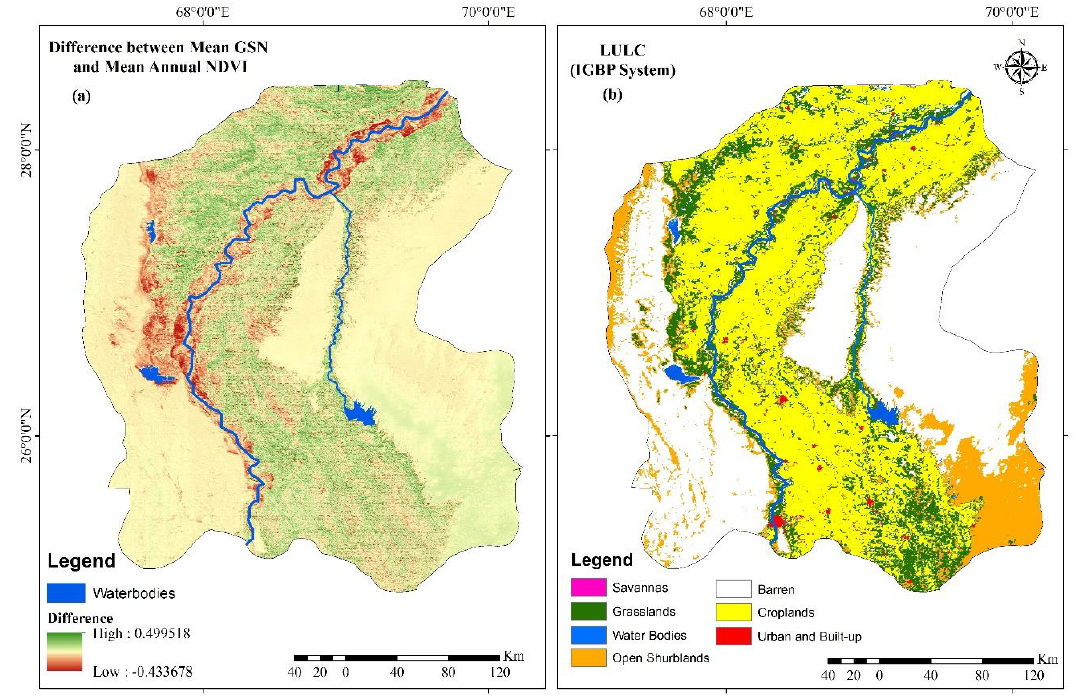
Figure 2. ( a ) Difference between Mean growing season (GS) and Mean Annual Normalized Difference Vegetation Index (NDVI) and ( b ) land cover map of arid regions of Sindh.